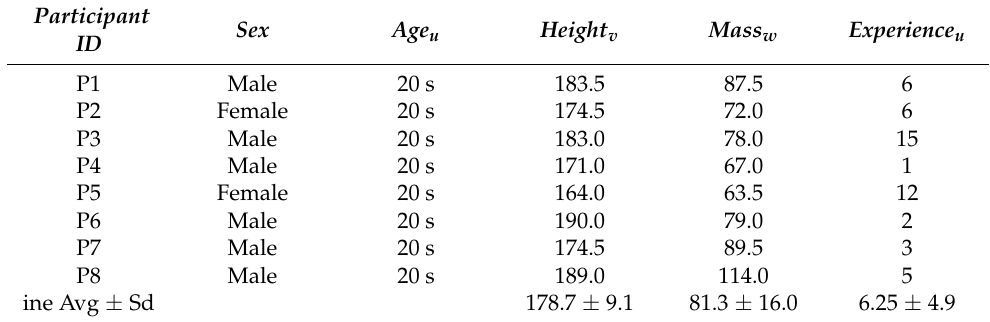
Table 1. Demographic data of